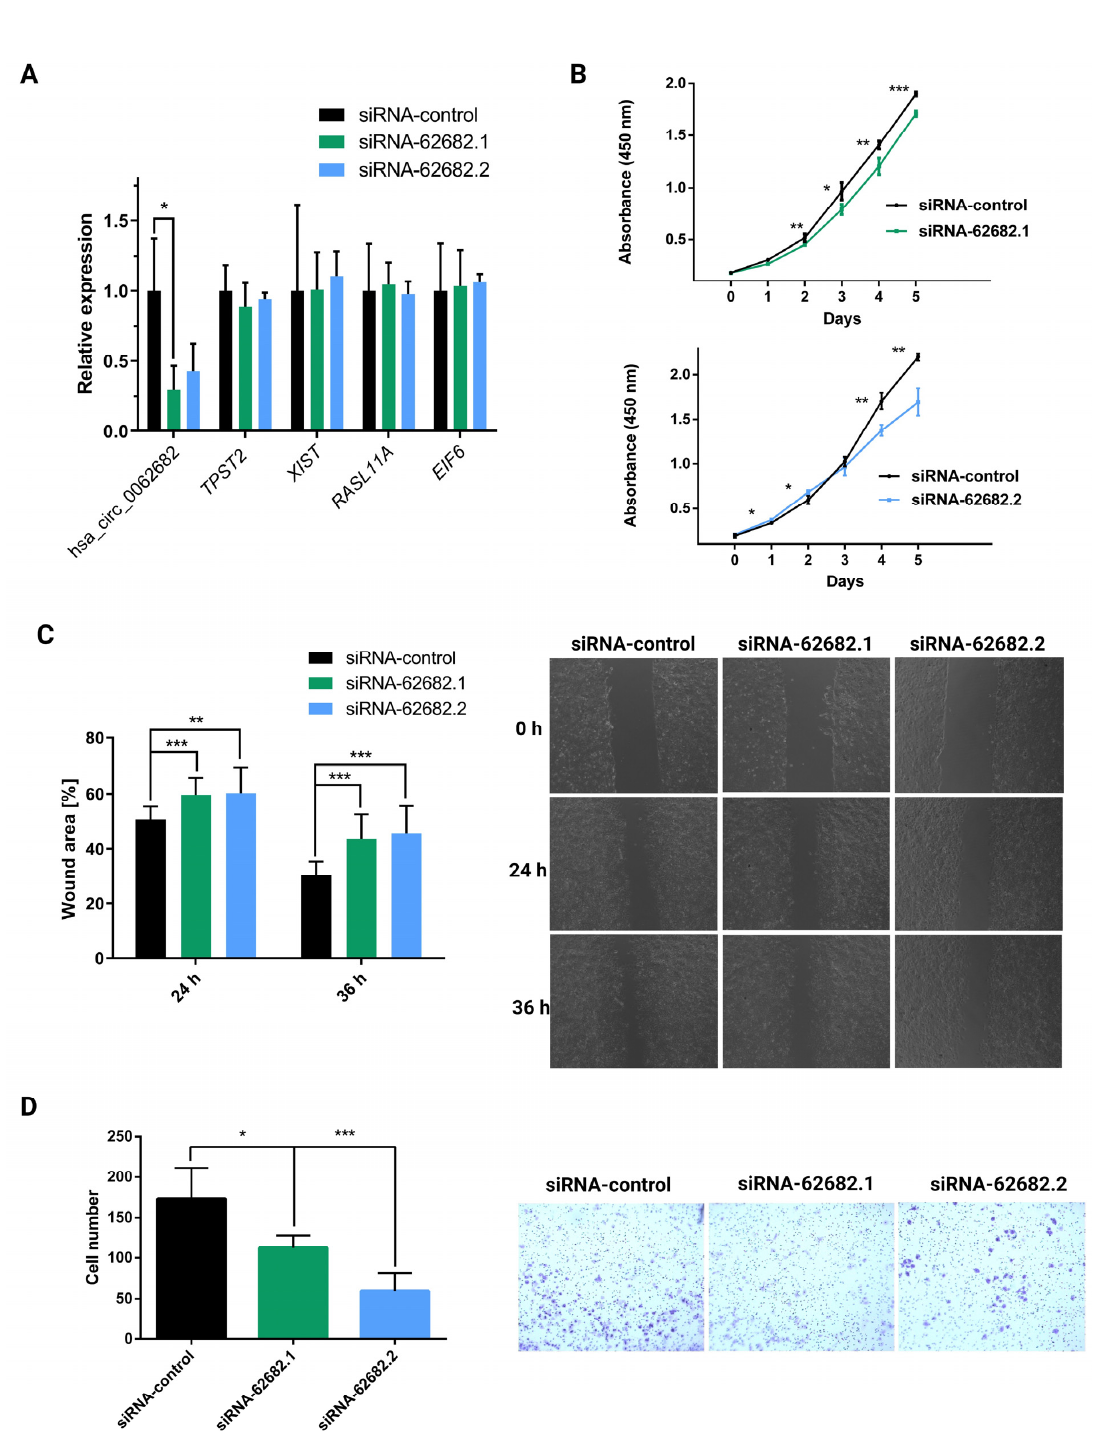
Figure 3. Transient knockdown of circular RNA hsa_circ_0062682 by two different siRNA sequences (siRNA-62682.1, siRNA-62682.2) decreased the oncogenic potential of the Huh-7 model cell line. ( A ) Relative expression of hsa_circ_0062682 and potential off-targets identified by nucleotide BLAST in Huh-7 cell line (n = 3); ( B ) proliferation of Huh-7 cell line with a knockdown of hsa_circ_0062682 (n = 4); ( C ) wound healing assay of Huh-7 cell line with a knockdown of hsa_circ_0062682 (n = 12); on the right representative images of Huh-7 migration are shown; ( D ) invasion assay of Huh-7 cell line with a knockdown of hsa_circ_0062682 (n = 18). Results are represented as averages and error bars represent standard deviation. * p -value ≤ 0.05; ** p -value ≤ 0.01; *** p -value ≤ 0.001, Student’s t